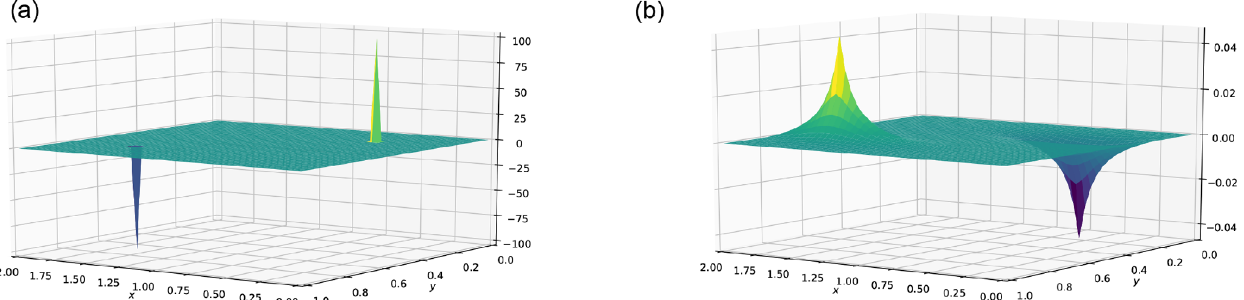
Figure 20. Right-hand side (a) and solution (b) of the Poisson